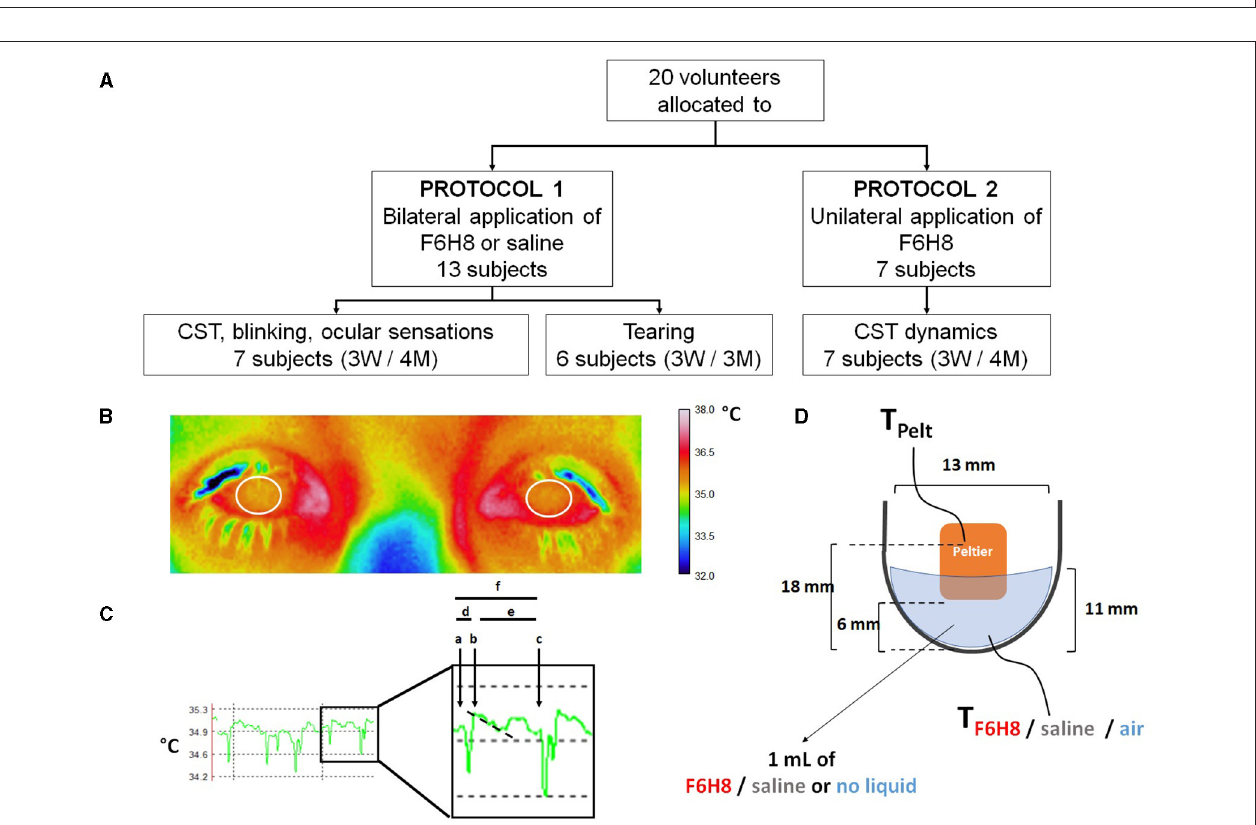
FIGURE 2 | (A) Distribution of volunteer participants among the different experimental protocols of the pilot study. In experimental protocol 1, perfluorohexyloctane (F6H8) or saline solution were applied to both eyes, while in experimental protocol 2, F6H8 was applied only to the right eye. CST: corneal surface temperature. (B) CST was calculated from infrared thermographic video images. Temperature values of a 1 cm 2 area of the corneal surface (white circumferences) were averaged to obtain the CST value at a defined time point. (C) Parameters measured from infrared thermographic video images of the corneal surface. Six interblink intervals were randomly selected and analyzed to obtain the following variables: (a) CST value immediately before a blink; (b) CST value immediately after blink; (c) CST value immediately before the next blink; (d) CST change during a blink, calculated as b-a; (e) CST change during the interblink interval, calculated as c-b; and (f) CST change between consecutive blinks, calculated as c-a. The time between a and b was considered as the duration of the blink movement. Also, the slope of the temperature decay during the first second of the IBI was calculated (dotted line). (D) Schematic representation of the experimental set-up used to measure the dynamics of temperature changes of F6H8 and saline solution during temperature changes induced with a Peltier cell placed inside the liquid in a tube. Temperature was measured with a thermocouple submerged into the liquid contained in a tube. TPelt: temperature of the Peltier cell measured with a PT100 sensor. TF6H8, TSaline and TAir: temperature measured with a thermocouple placed inside F6H8, saline solution, or an empty container, respectively.